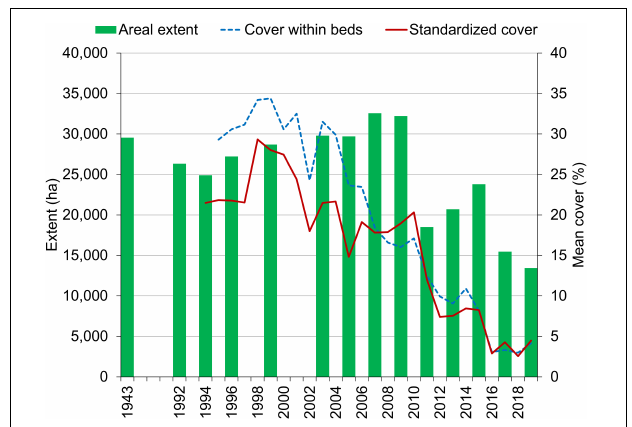
FIGURE 3 | Areal extent of seagrass in maps derived from aerial imagery and percent cover derived from surveys of fixed